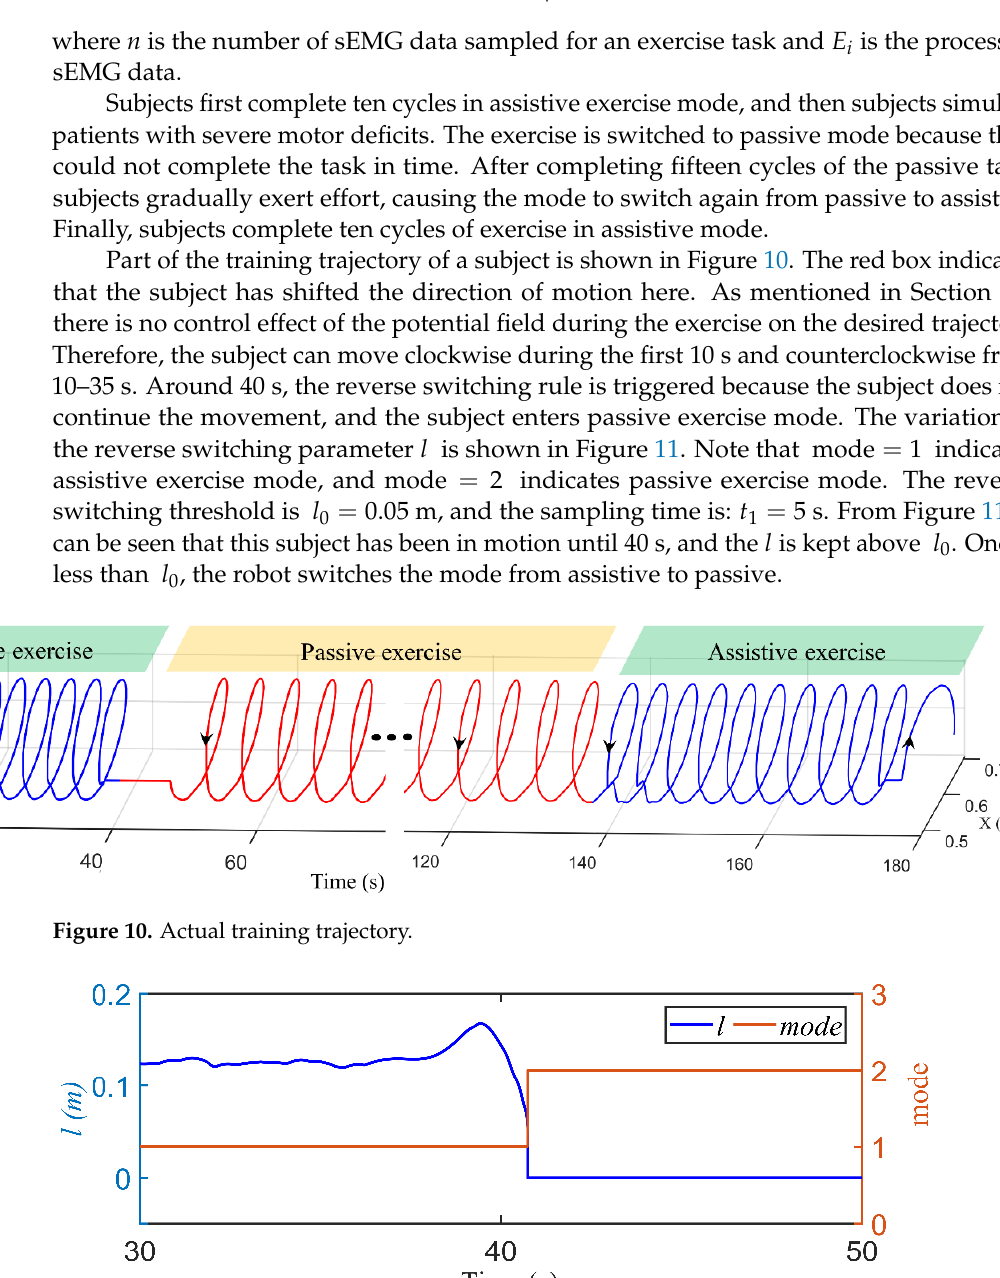
Figure 11. Reverse switching parameter 𝑙.